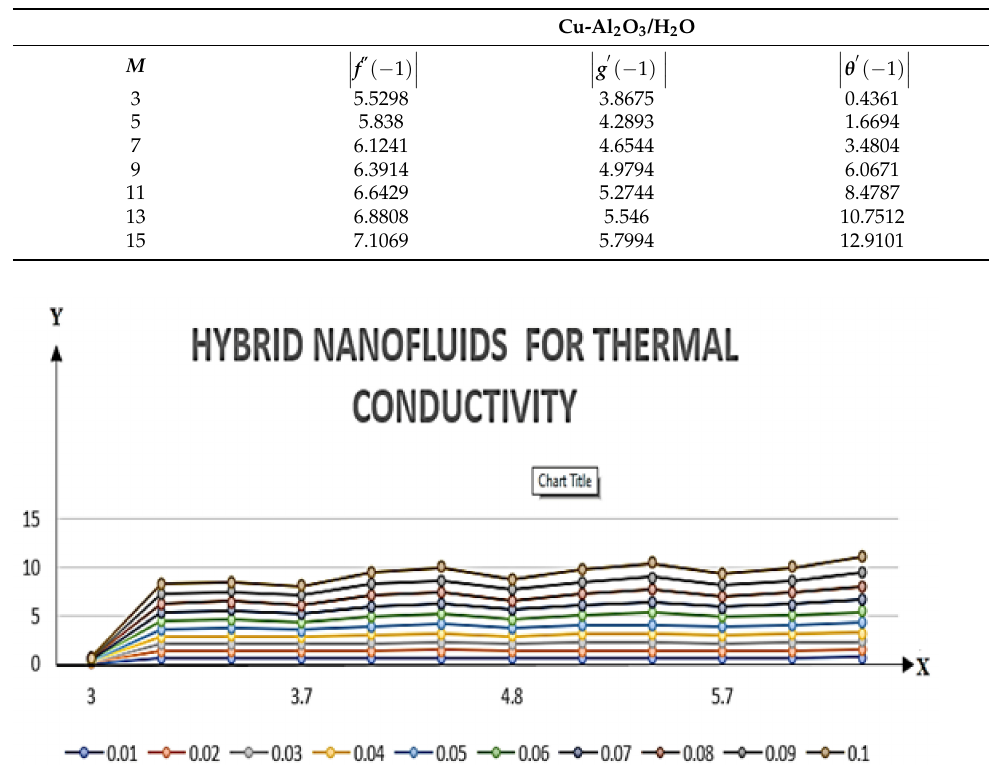
Table 7. Magnetic-filed effect in f (cid:48)(cid:48) ( η ) , g (cid:48) ( η ) and θ (cid:48) ( η ) at lower wall = − 1, Re = 1, ϕ 1 = ϕ 2 = 0.02, Ec = 0.00068, Pr = 6.2.